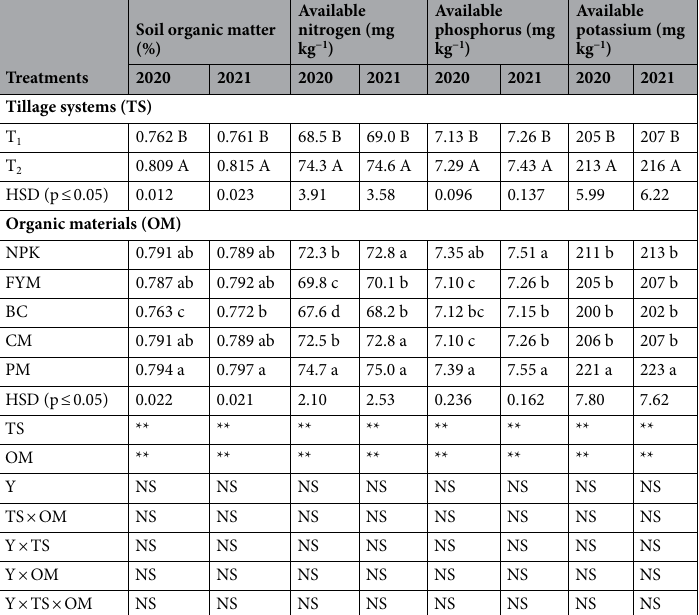
Table 4. Effect of different tillage systems and organic materials on the soil health indices. Values sharing the same alphabet letters did not differ markedly at p ≤ 0.05 for a particular trait. NS non-significant p ≤ 0.05, T